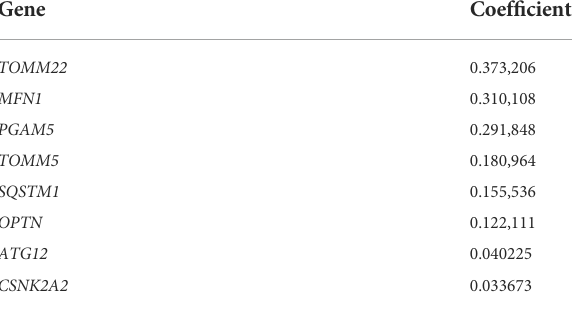
TABLE.2 Eight genes for prognostic model and their risk coef fi